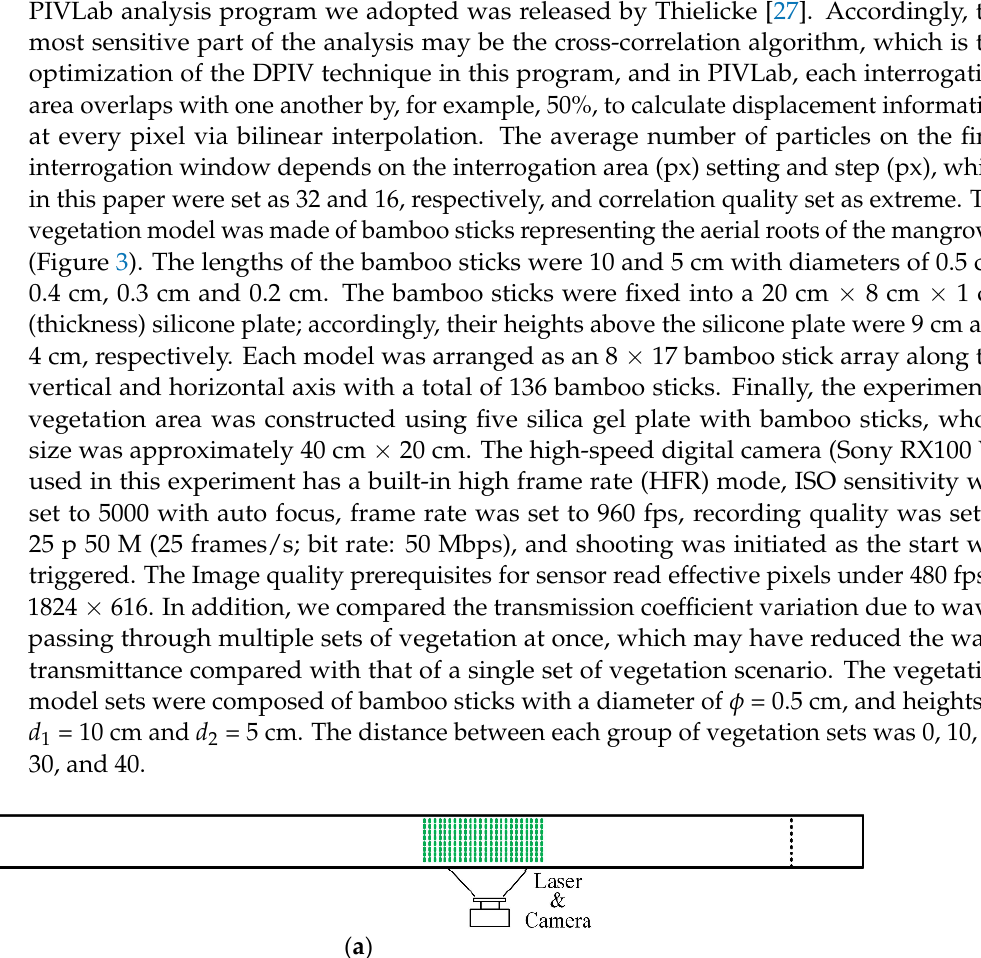
Figure 1. Photographs of experimental set-up.